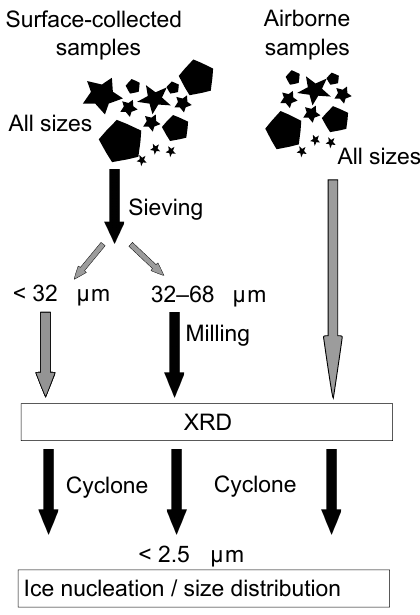
Figure 2. Schematic of size fractions used for XRD and ice nucle-